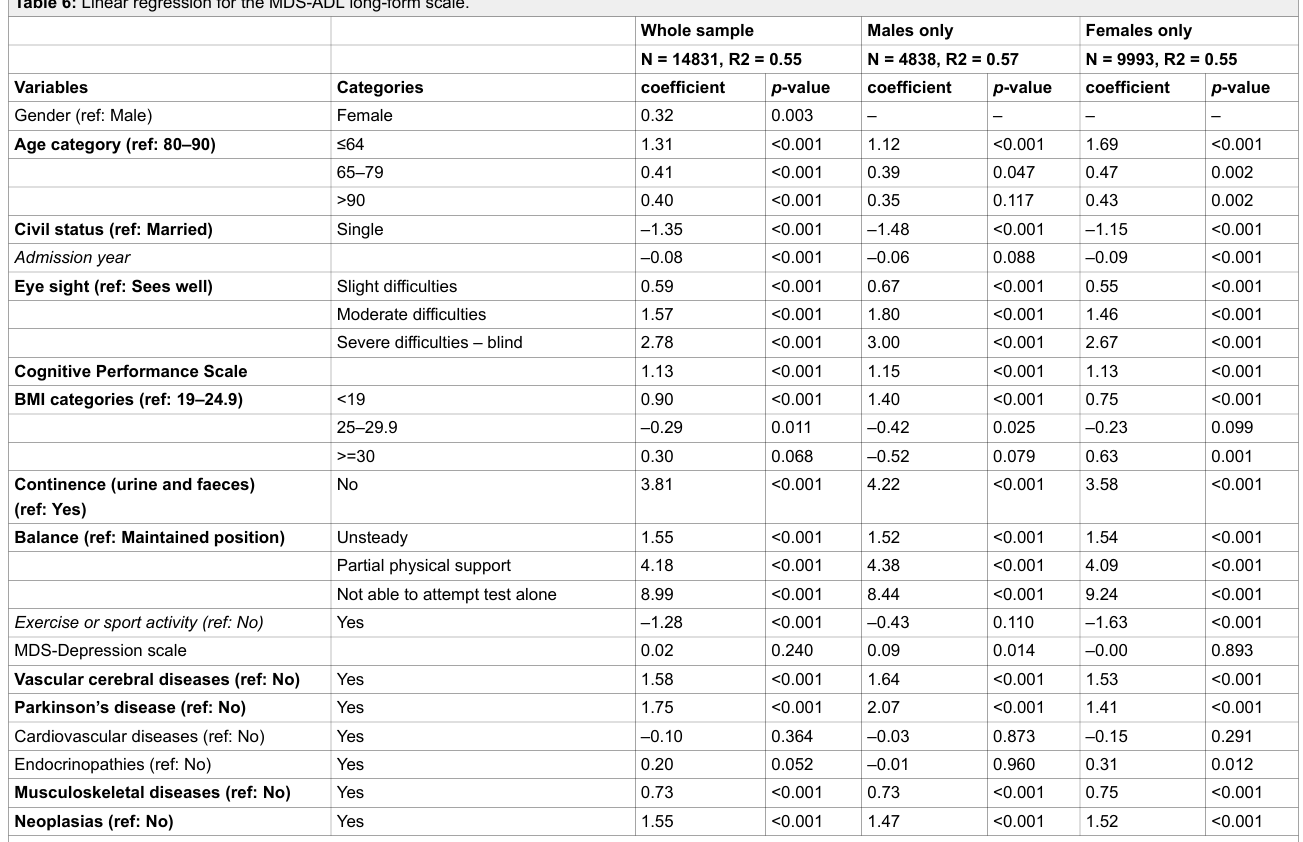
Table 6: Linear regression for the MDS-ADL long-form scale.